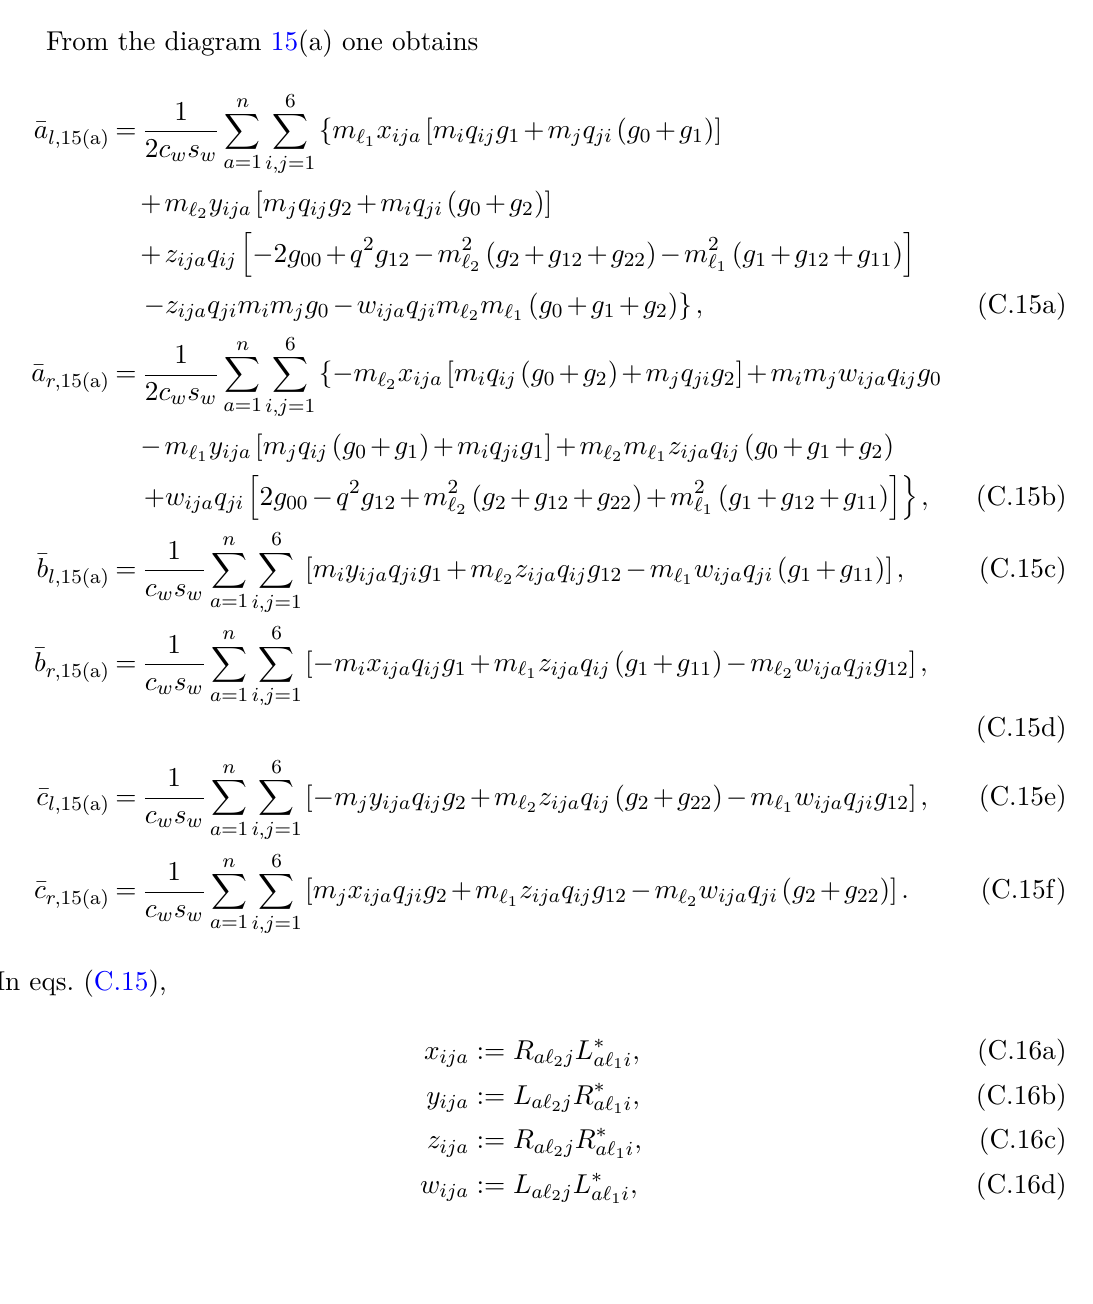
From the diagram 15(a) one